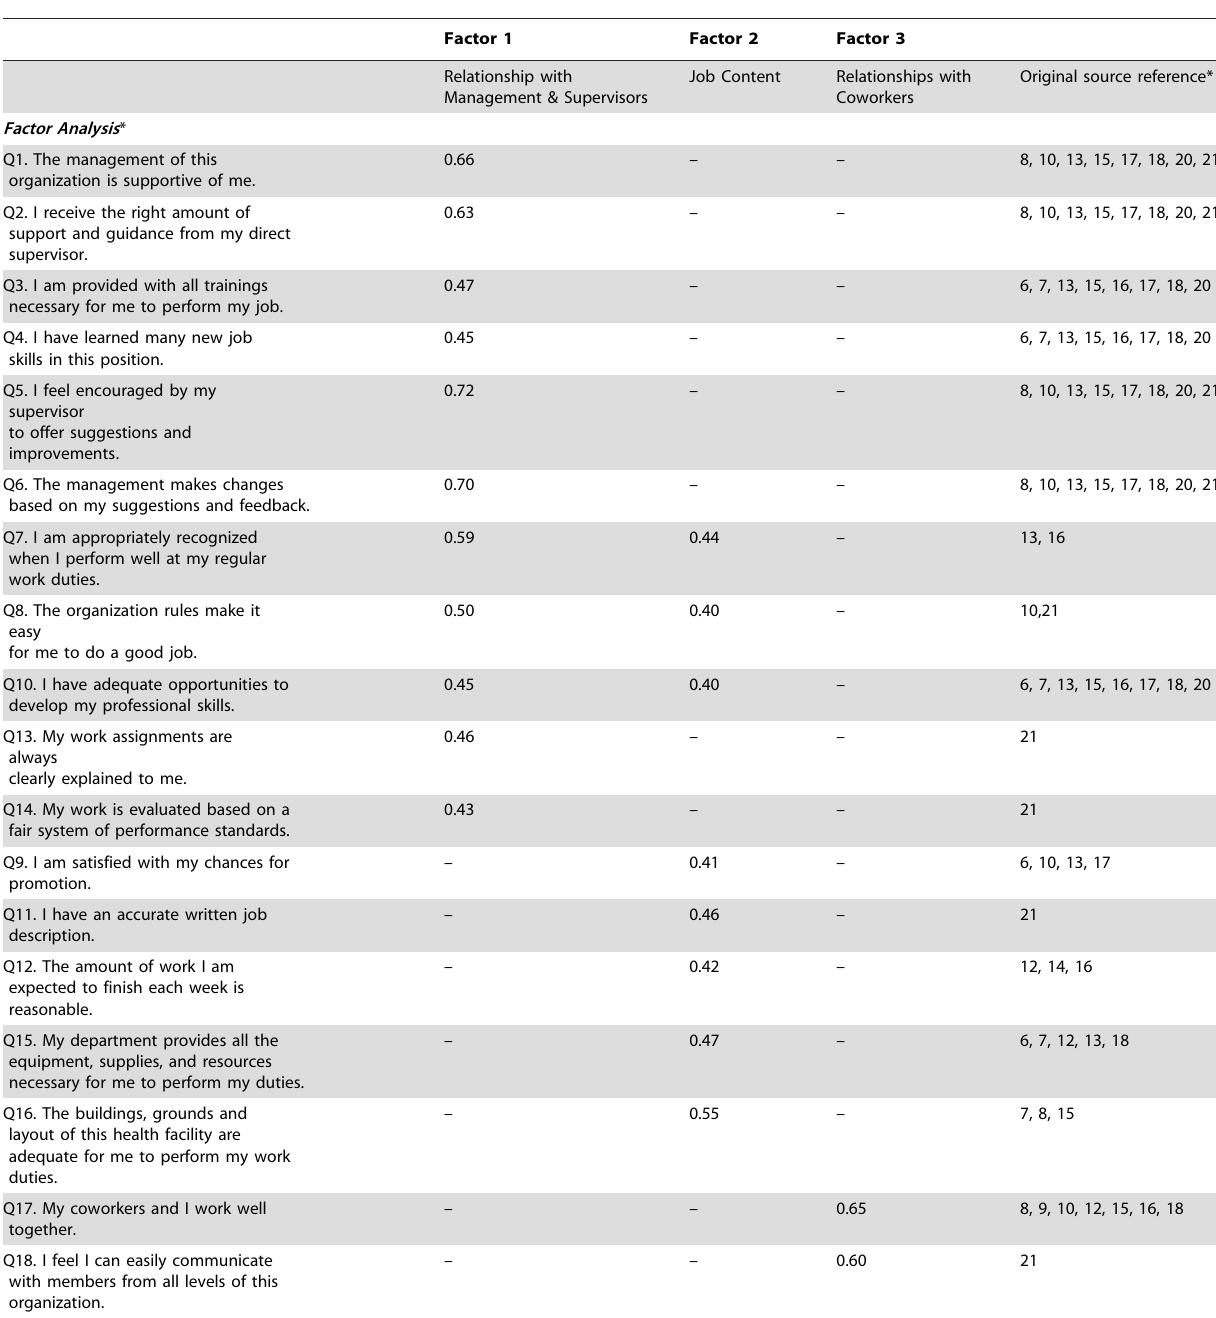
Table 2. Factor analysis of staff satisfaction survey item (N